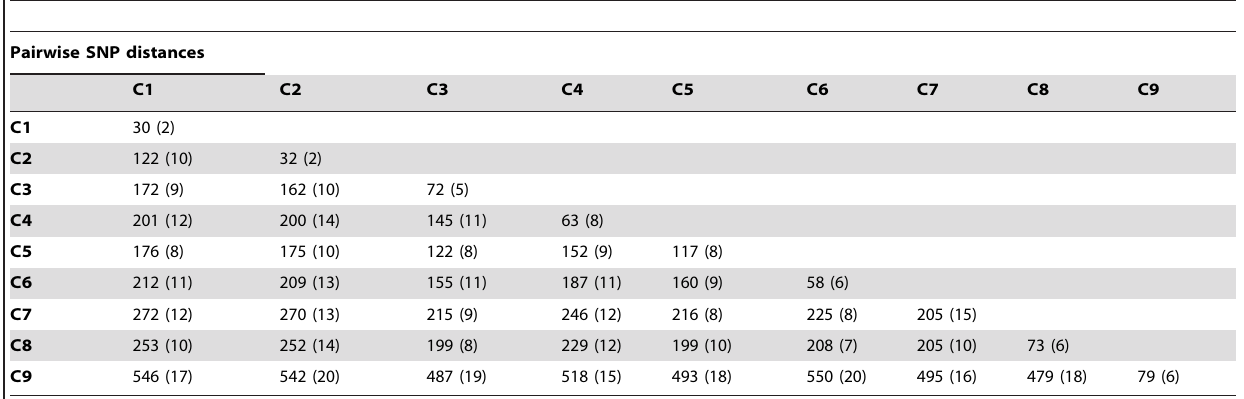
Table 2. Pairwise SNP distances + / 2 SD between major lineages identified in the phylogenetic tree (C=clade).